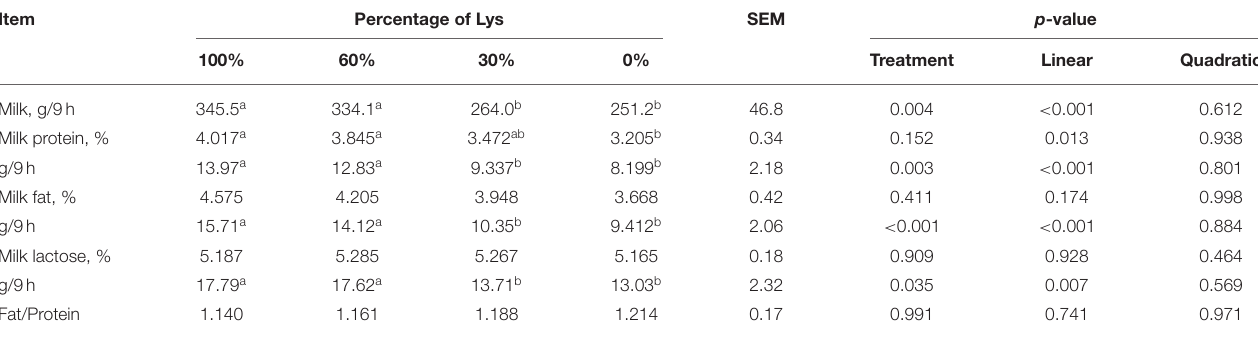
FIGURE 1 | Concentrations of urea and glucose in arterial plasma after infusion of glucose and amino acid into abomasum in a preliminary experiment. TABLE 3 | Effects of graded removal of Lys from the amino acid mixture infused into abomasum on lactation performance of lactating